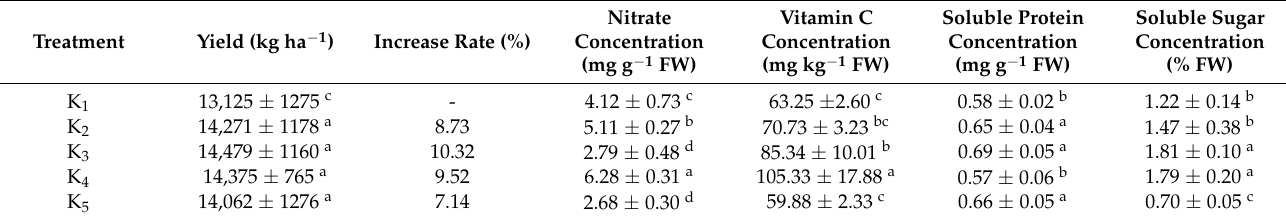
Table 4. Effect of different K application rates on yield and quality of lettuce.